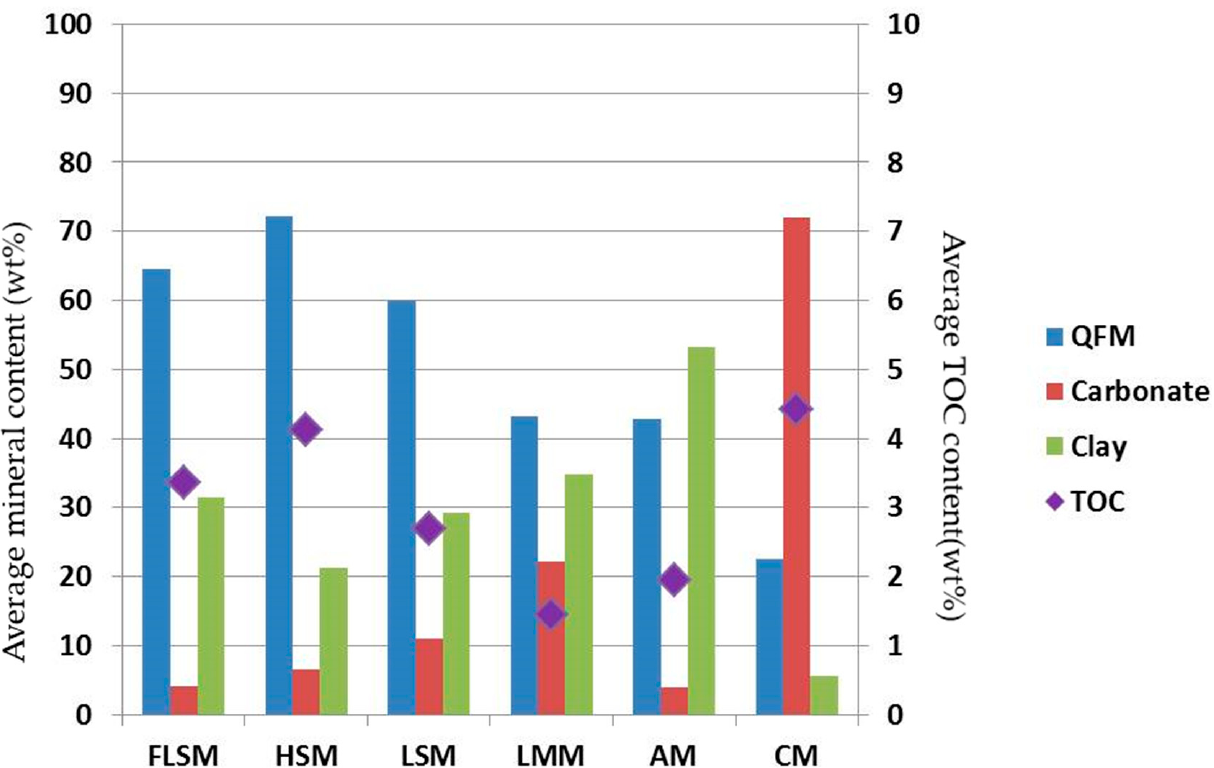
Figure 3. Mineralogical compositions of the six core facies. FLSM: faintly laminated siliceous mud- stone. HSM: homogeneous laminated siliceous mudstone. LSM: laminated siliceous mudstone. LMM: laminated mixed mudstone. AM: argillaceous mudstone. CM: calcareous mudstone. QFM: quartz, feldspar, and mica. TOC: total organic carbon contents.